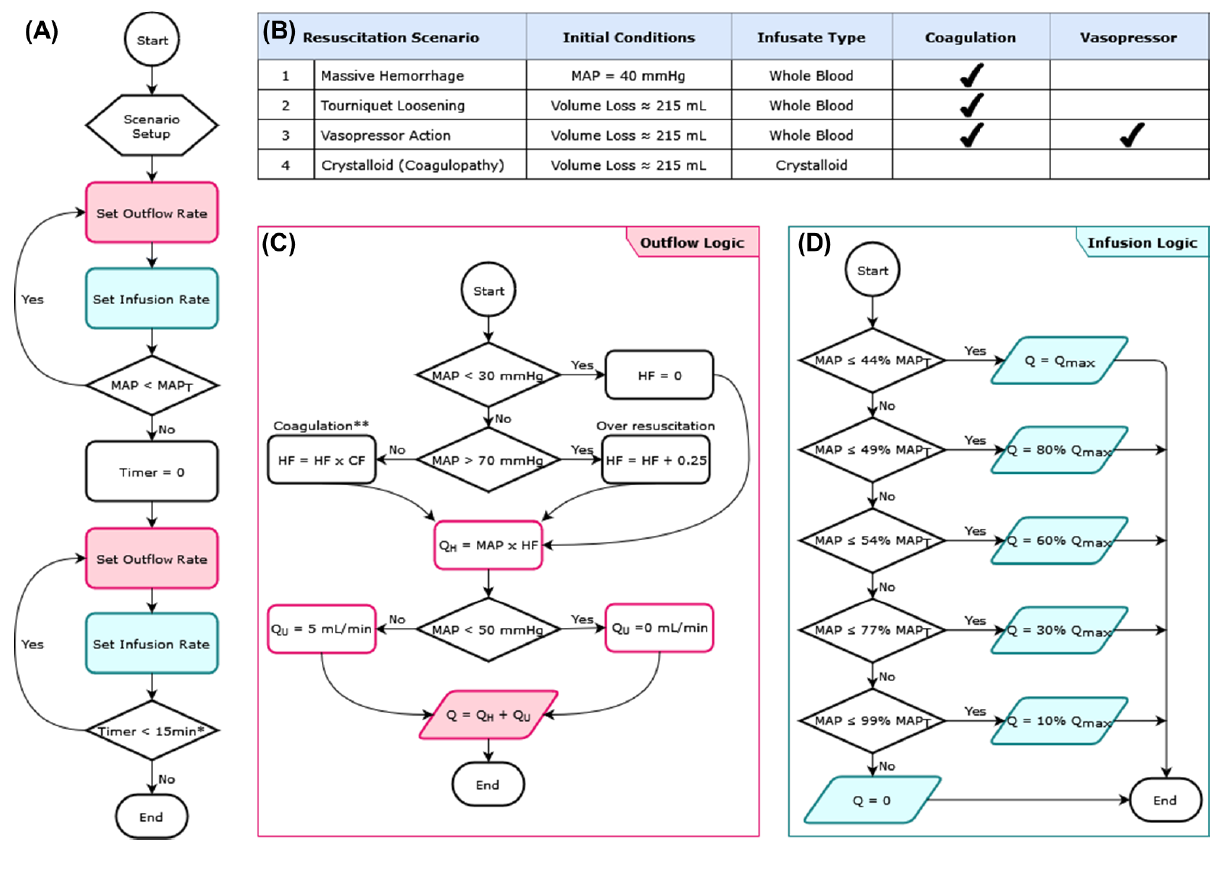
Figure 2. Logical components driving the HATRC platform. (A) Sequence of steps in the execution of each scenario. (B) List of simulated scenarios used to evaluate resuscitation controllers and features chosen for each. (C) Logic for calculating the rate for the outflow pump. (D) Logic for calculating the rate for the infusion pump; this decision table logic was adapted from Marques et al., 2017 [11]. * The timer logic for the fourth scenario was modified to allow it to run for 30 min. ** The “ Coagulation ” logic was disabled for the fourth scenario. MAP = mean arterial pressure; MAP T = target MAP; Q = pump rate; Q max = maximum pump rate; Q H = hemorrhage rate; Q U = urine rate; HF = hemorrhage factor; CF = coagulation factor.